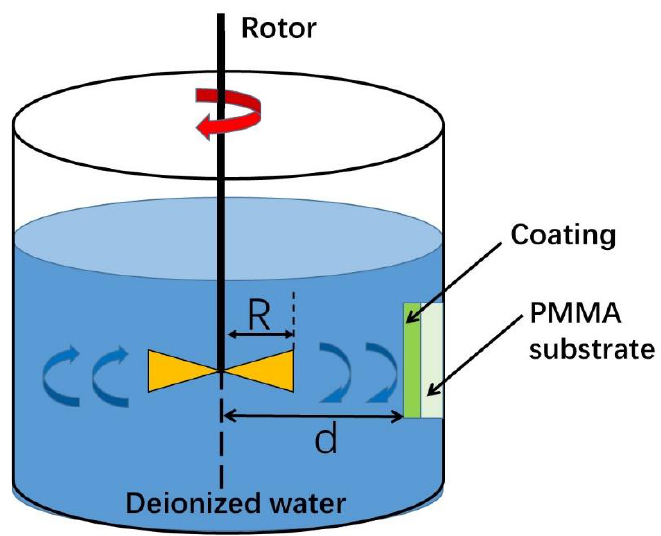
Figure 1. Schematic diagram of water-flow scouring test.